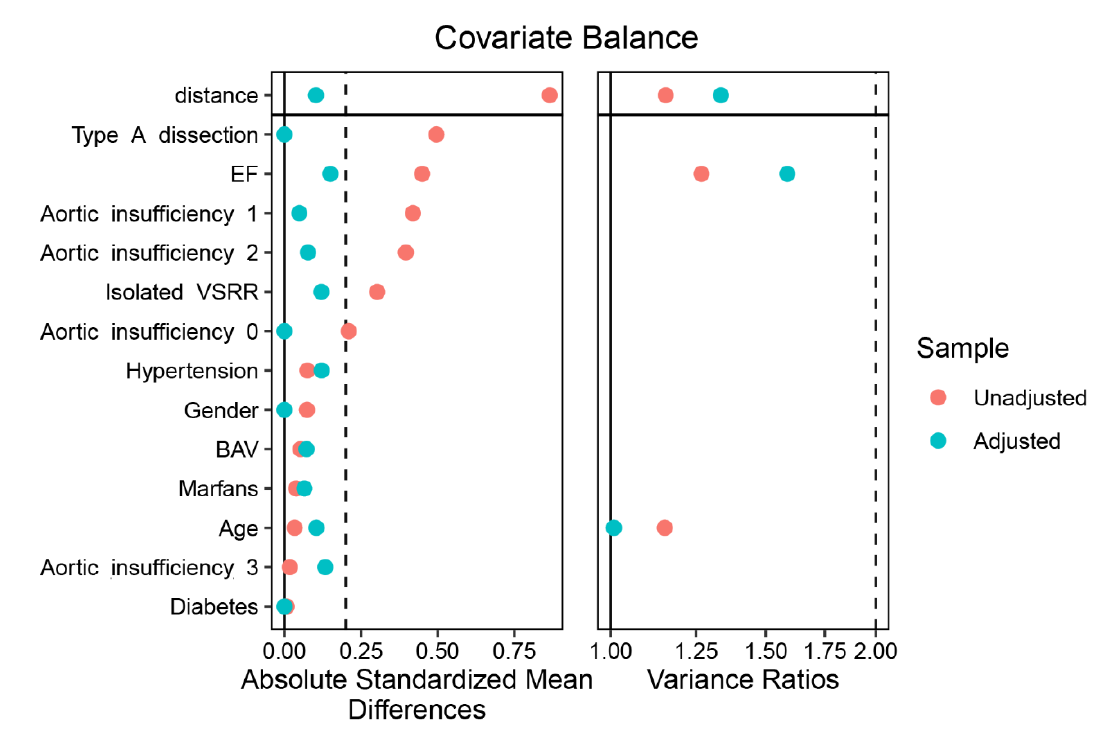
Figure 3. Standardized mean differences for sternotomy pairwise comparisons via the LOVE plot.